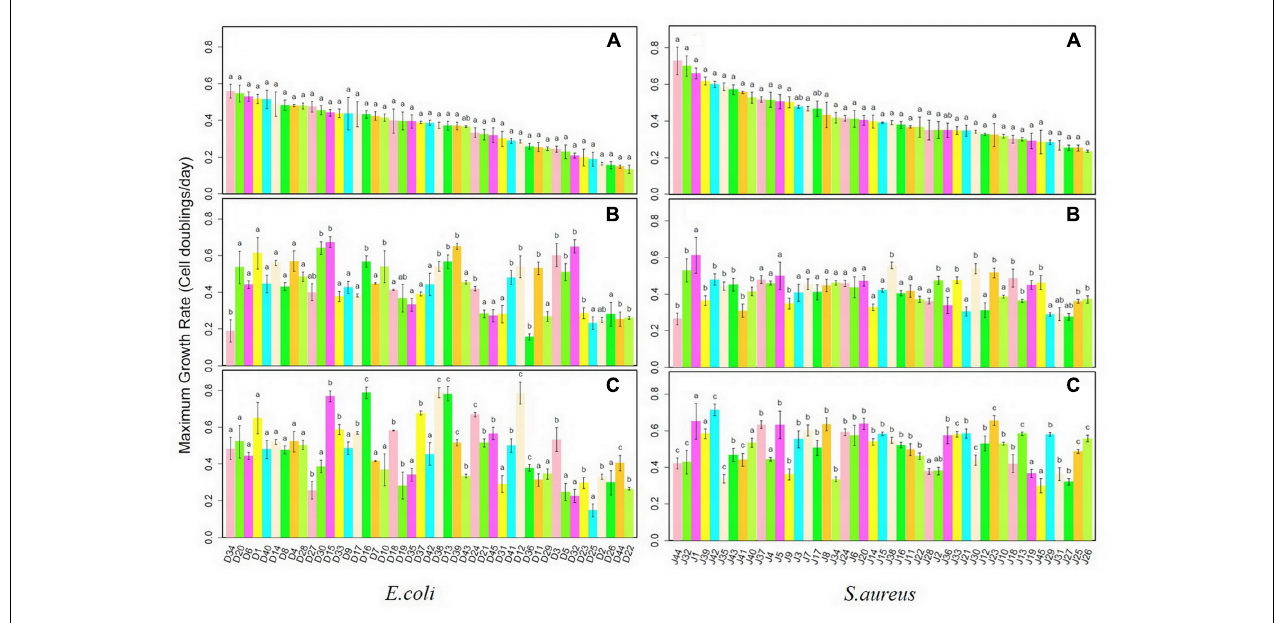
FIGURE 1 | Maximum growth rates for Escherichia coli and Staphylococcus aureus strains after monoculture and co-culture. (A) Initial Strains; (B) monoculture; (C) co-culture.